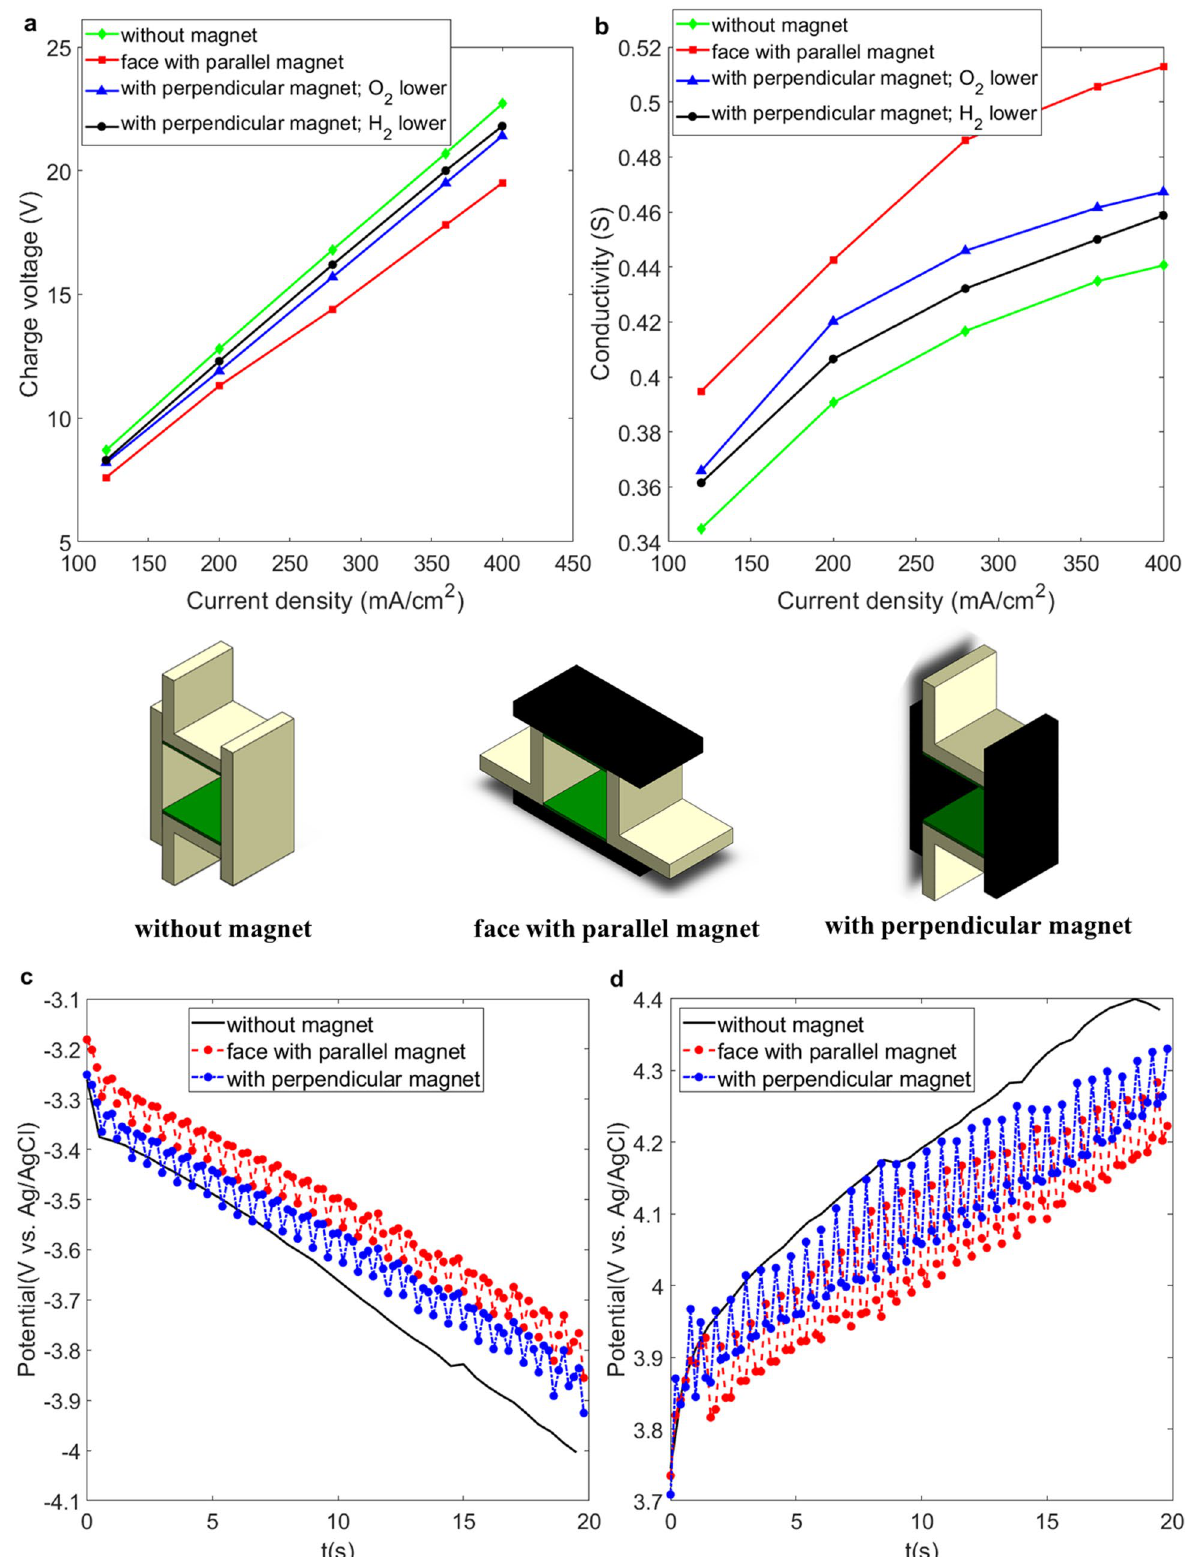
Figure 2. Comparison of the conductivity for horizontal platinum electrodes in various configurations of magnetic field. ( a ) Charging voltage vs. current density for the experimental layouts shown in Fig. 1a–c. ( b ) Conductivity vs. current density for the experimental layouts shown in Fig. 1a–c. ( c ) Polarized potential curve for the reduction reaction (cathode). ( d ) Polarized potential curve for the oxidation reaction (anode). The potential was measured at current densities of 200 mA/cm 2 with the scan rate of 10